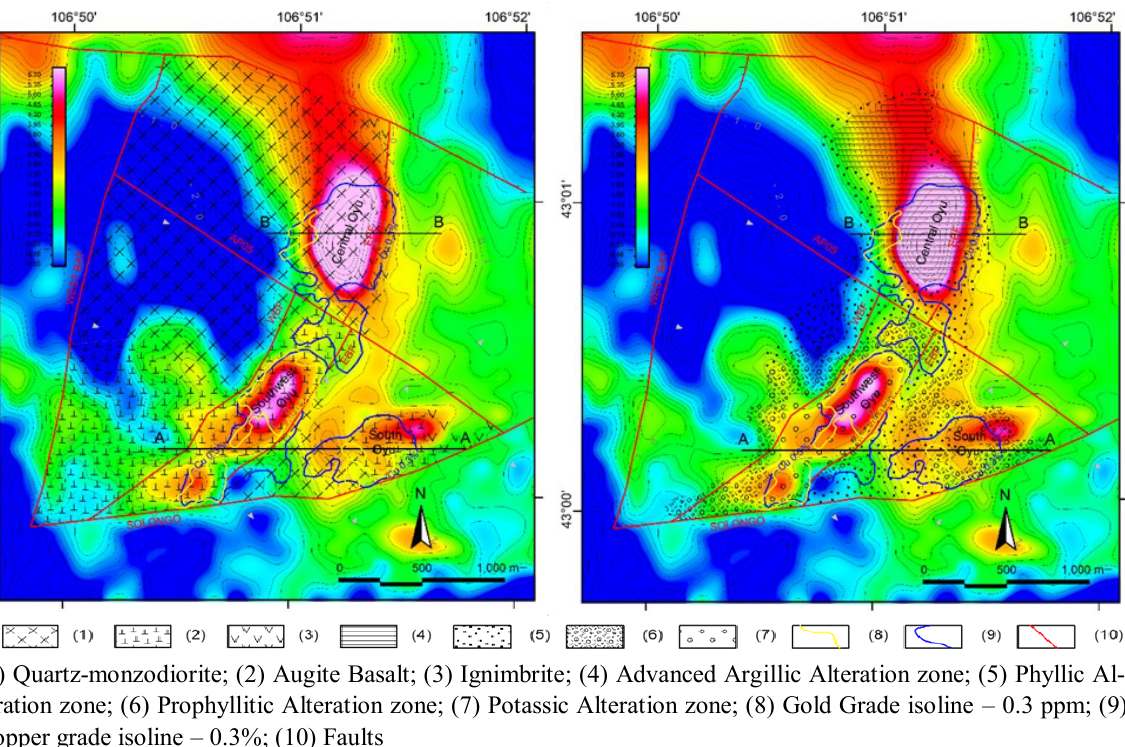
( 1) Quartz-monzodiorite; (2) Augite Basalt; (3) Ignimbrite; (4) Advanced Argillic alteration zone; (5) Phyllic alteration zone; (6) Prophyllitic alteration zone; (7) Potassic alteration zone; (8) Gold grade isoline – 0.3 ppm; (9) Copper grade isoline – 0.3%; (10) Faults Fig. 7. Residual Gravity anomalies map (regional response removed by 1 st trend surface removal method): Residual Gravity overlapping with lithology (left), Residual Gravity overlapping with alteration zones (right);